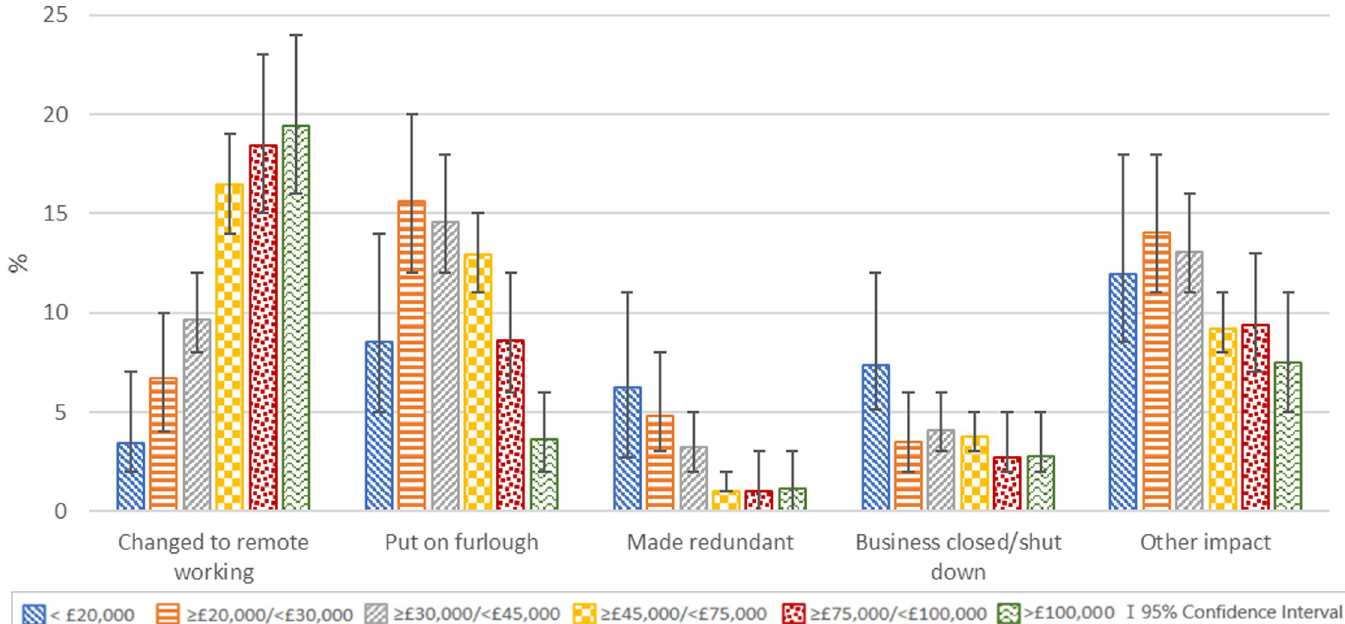
Fig 2. Impact of the COVID-19 pandemic on partner employment by household income in the COVID-19 New Mum Study; %.